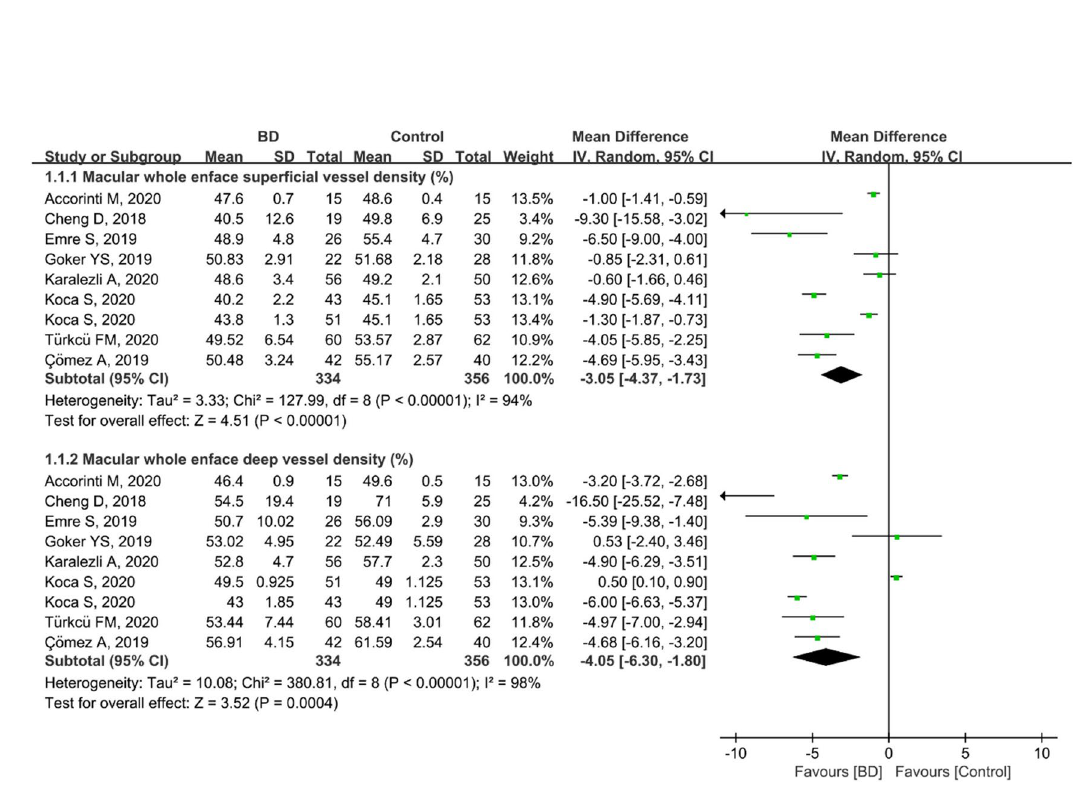
Figure 2. Forest plot for macular whole enface superficial and deep vessel density between BD and control